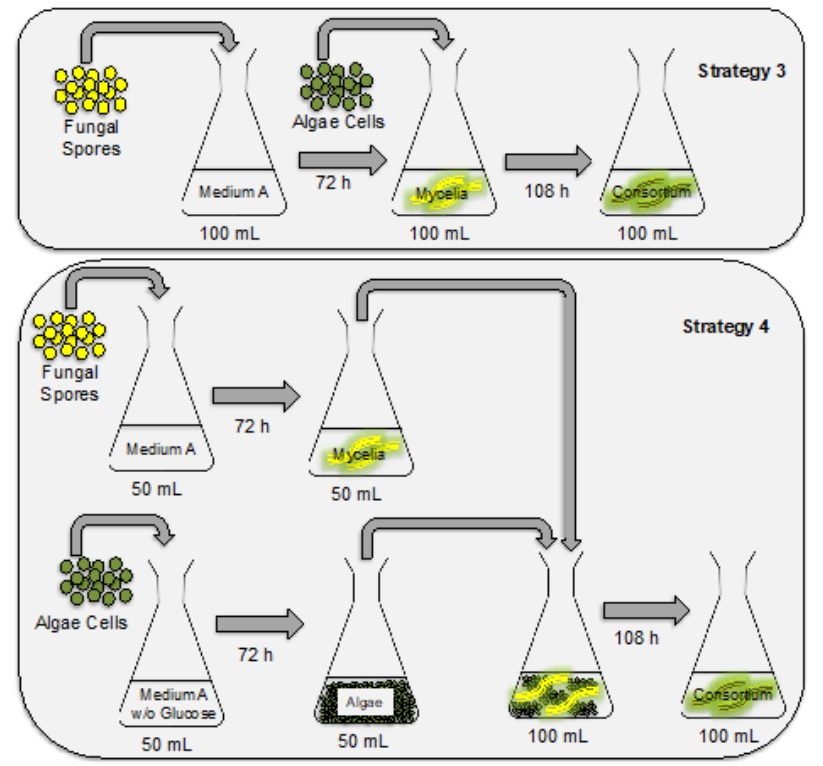
Figure 3. Schematic illustration of strategies 3 and 4. 225